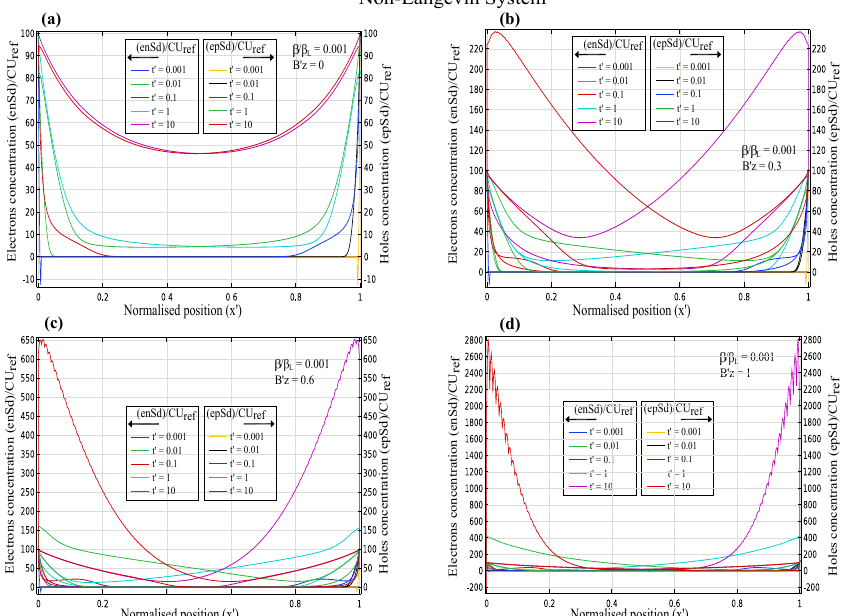
Figure 3. Time-dependent charge carrier concentration for electrons and holes as a function of normalised position x (cid:48) with varying magnetic fields of ( a ) B (cid:48) = 1 for non-Langevin system with β ( d ) B (cid:48) z